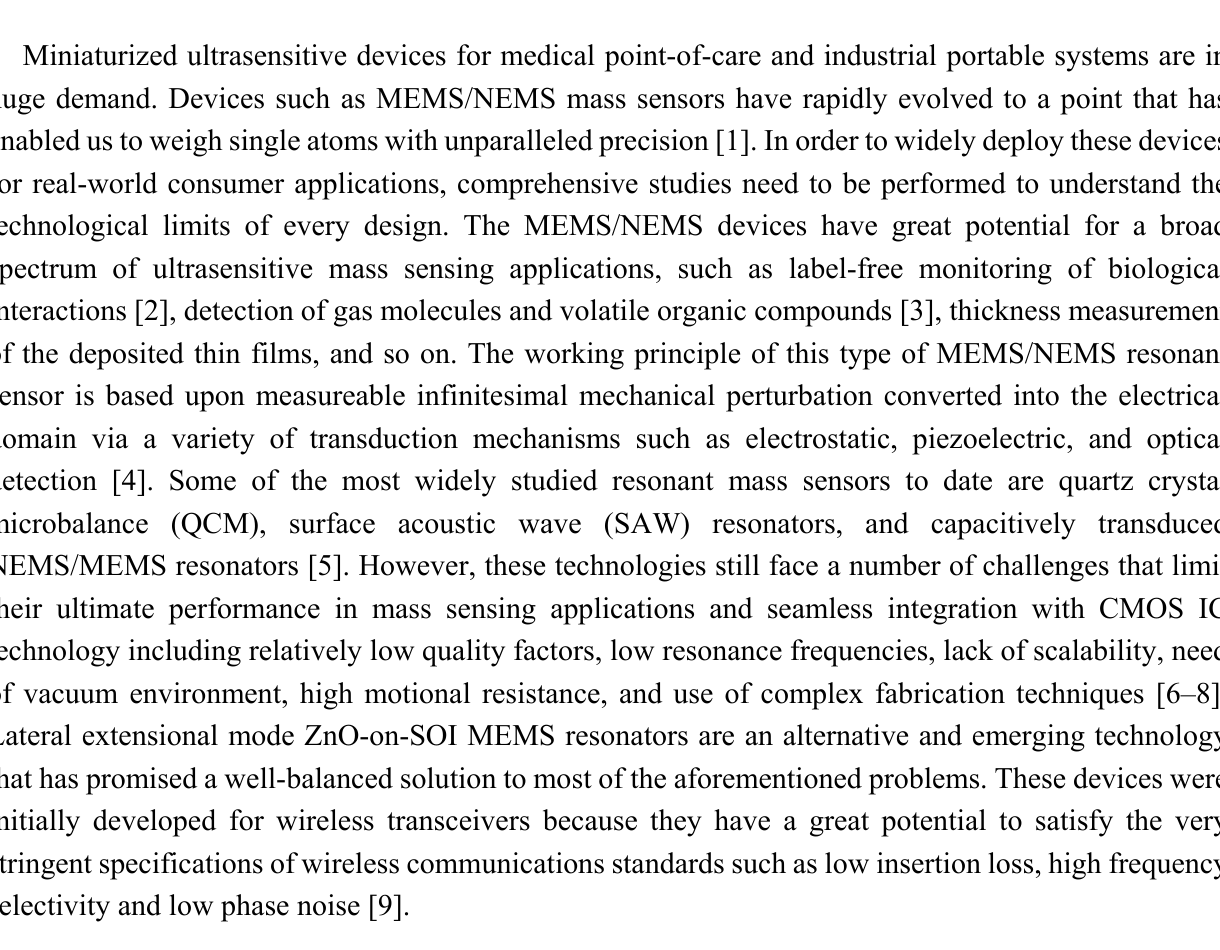
Table 1. Comparison of resonant sensing technologies evaluated by direct metal writing